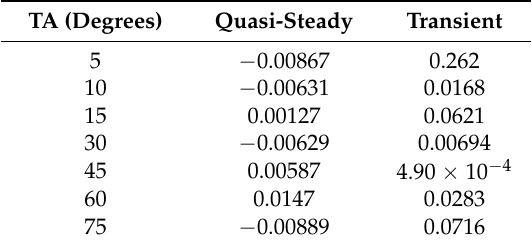
Table 8. Wing pitching moment coefficients by both methods.